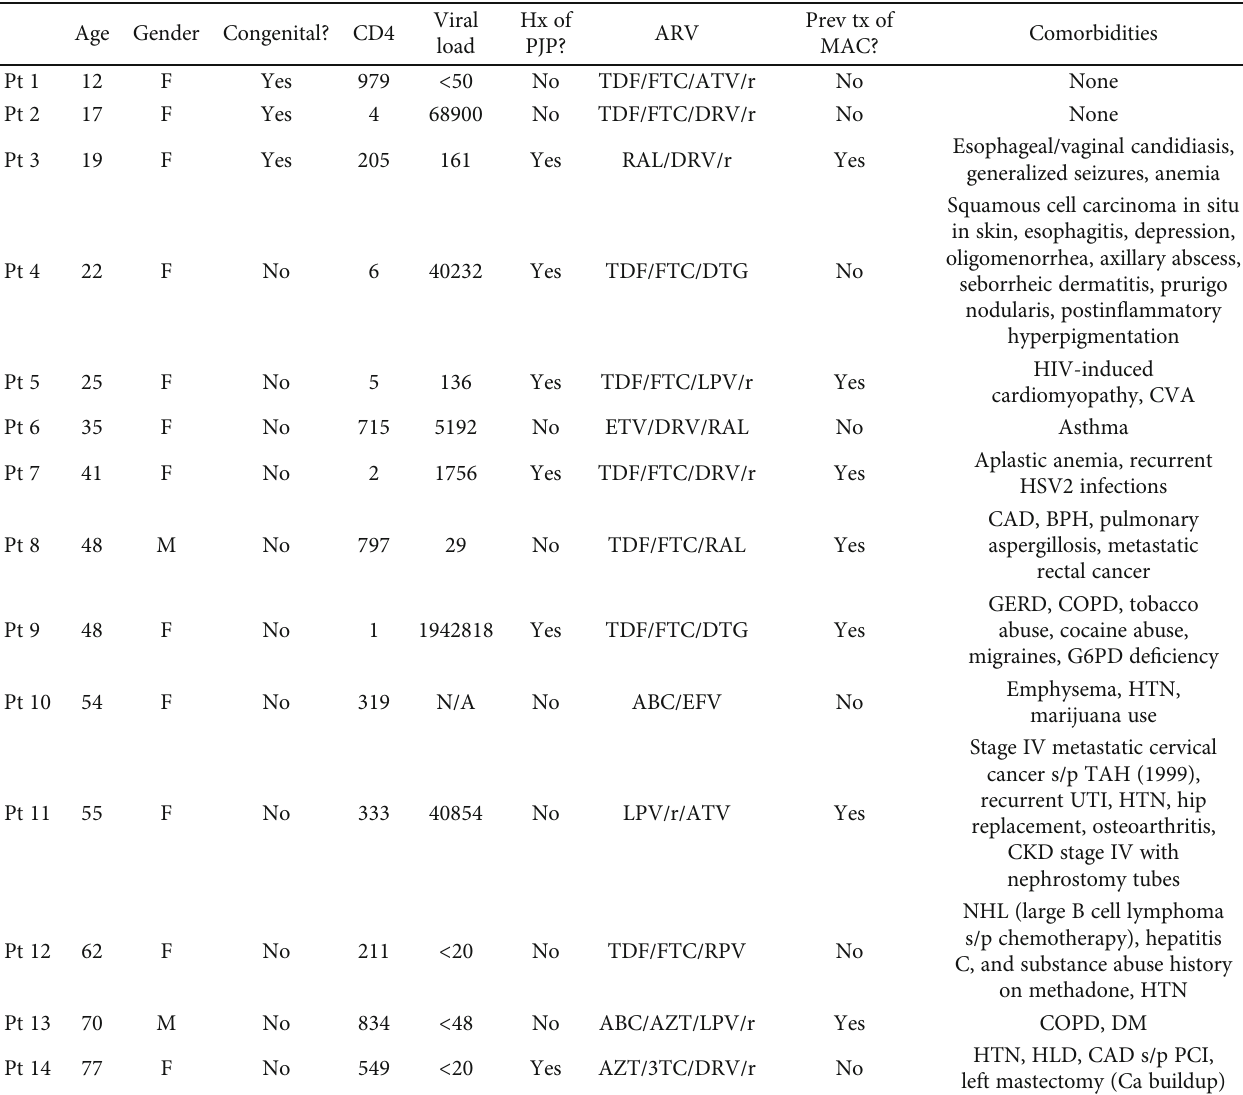
Table 1: Patient characteristics and HIV/opportunistic infection history. Age Gender Congenital?